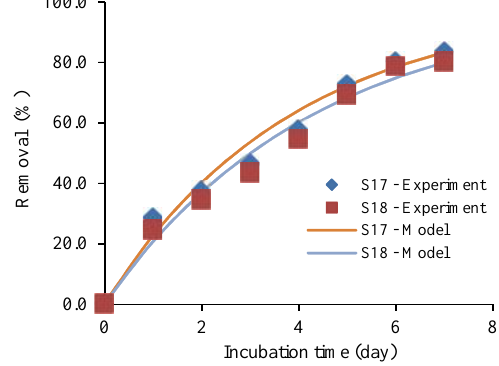
Fig. 6(e): Comparison of experimental and model values by A. foetidus Fig. 6(f): Comparison of experimental and model values by A. heteromorphus